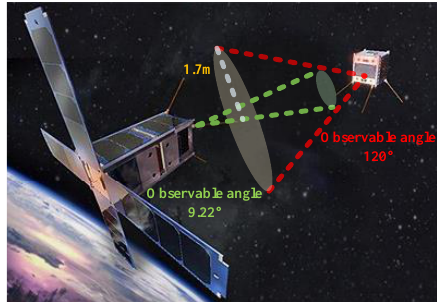
Figure 8. Schematic diagram of CANYVAL-X.